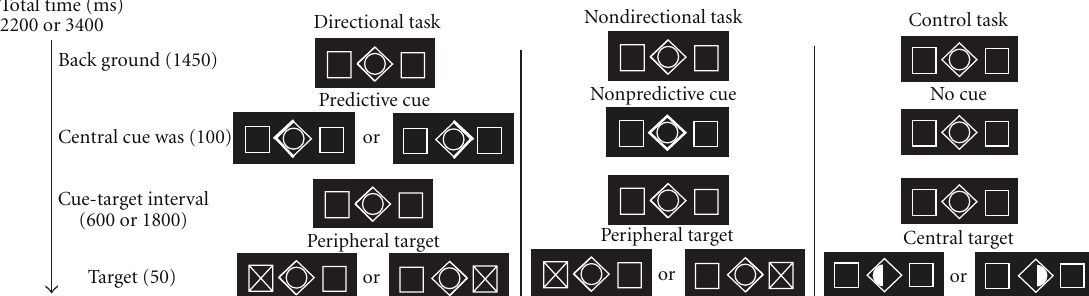
Figure 1: Experimental paradigm. In the Directional task, the visual cue indicates spatial information with a validity of 90%. The cue was illuminated for 100 ms and after the cue-target interval (600 or 1800 ms), the visual target was presented for 50 ms. During the Nondirectional task, a neutral cue was used that provided no spatial information. During the control task, the left or right half of the inner circle in the center of the screen would turn to white upon which the participants were asked press the reaction key. The reaction time was not recorded during this control